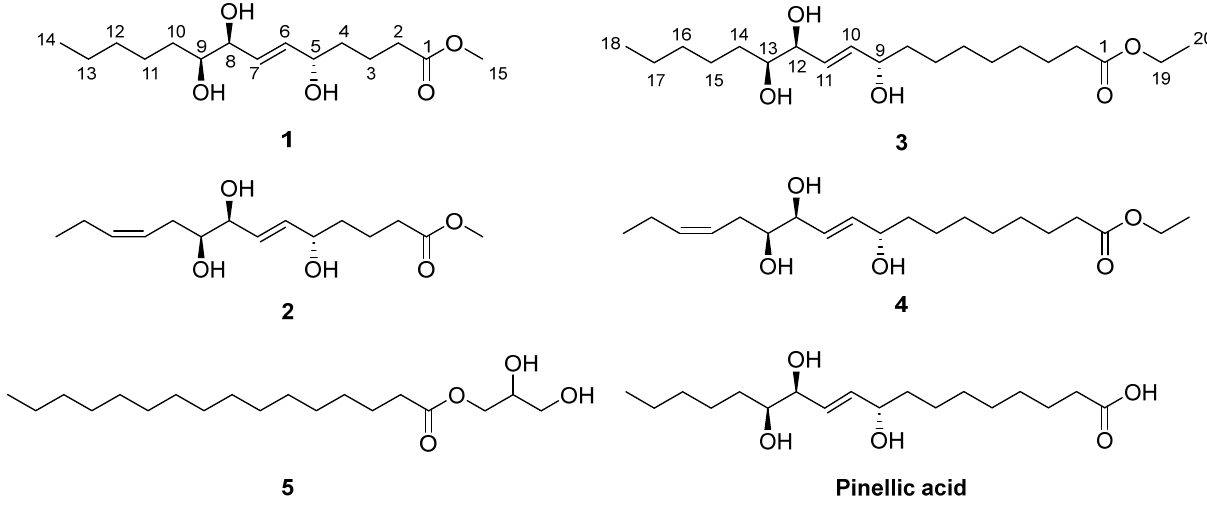
Figure 1. Chemical structures of the isolated compounds 1–5 and pinellic acid.